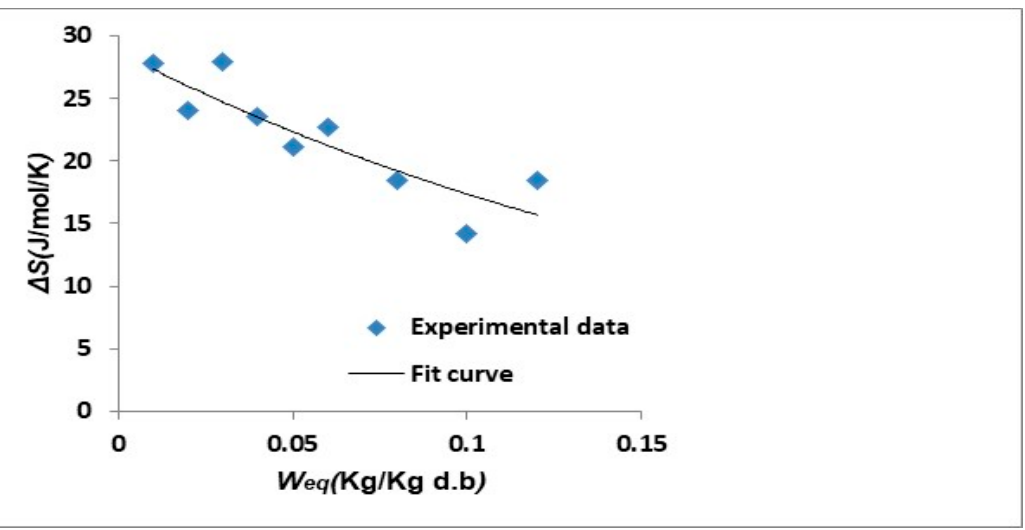
Figure 13. Differential entropy for water desorption from corn kernels as a function of equilibrium moisture content W eq .